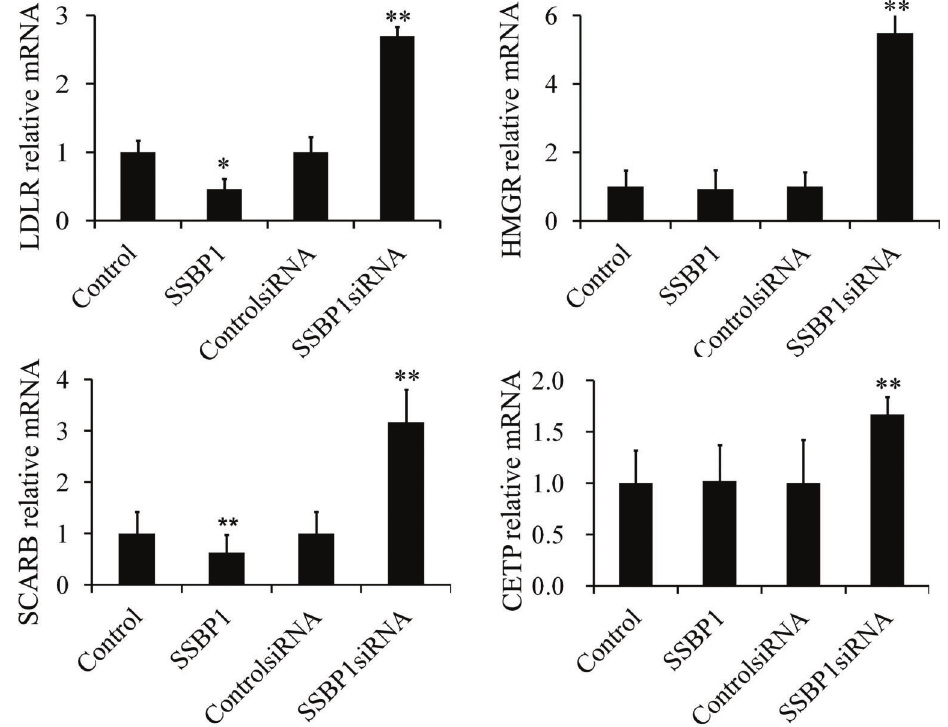
Figure 4. Single-stranded DNA-binding protein SSBP1 affected the expression levels of lipid metabolism-associated genes in human umbilical vein endothelial cells. The results of real-time PCR showed that over-expression of SSBP1 inhibited the expression of LDLR and SCARB, while knockdown of SSBP1 signi fi cantly promoted the mRNA expression of LDLR, HMGR, CETP and SCARB. LDLR: low- density lipoprotein receptor; SCARB: scavenger receptor B; HMGCR: HMG-CoA reductase; CETP: cholesteryl ester transfer protein. Data are reported as means ± SE, n=4. *P o 0.05 and **P o 0.01 vs control (ANOVA).